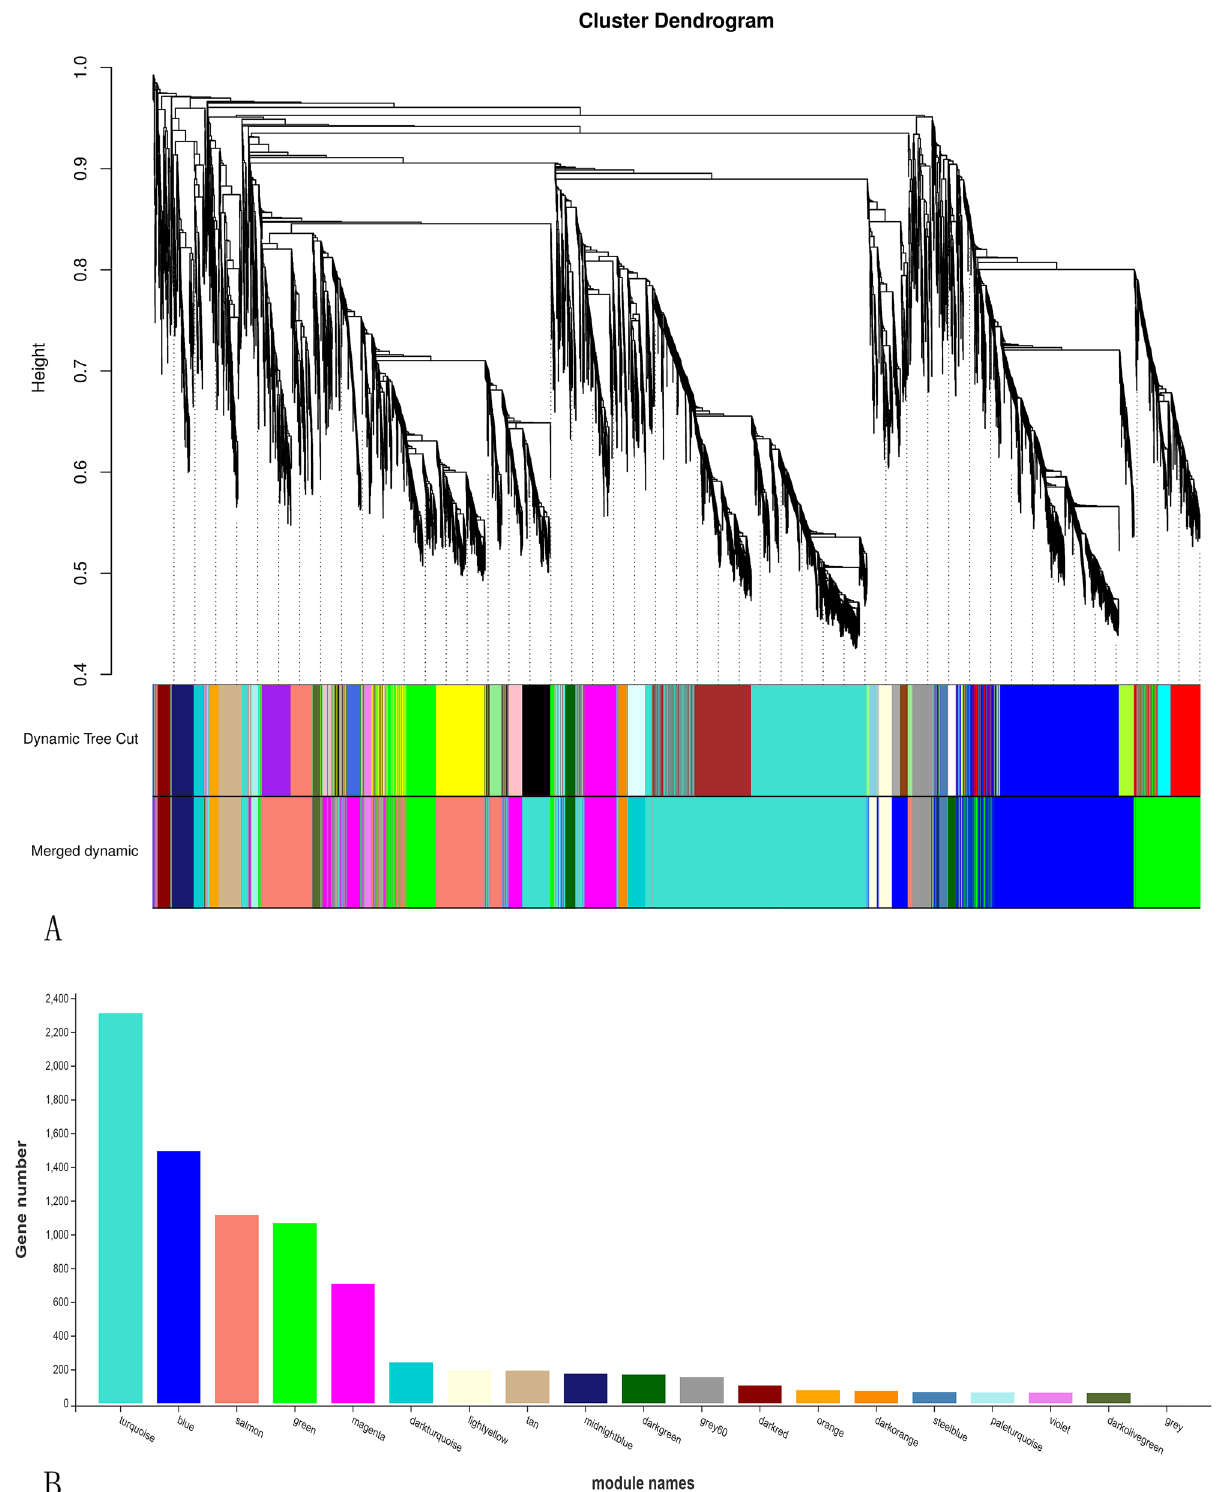
Figure 4. Nineteen different modules identified. ( A ) Gene co-expression network gene clustering number and modular cutting. Dynamic Tree Cut is the module divided according to clustering results. Merged Dynamic is the module division of merged modules with similar expression patterns according to module similarity. The subsequent analysis is conducted in accordance with merged modules. In the case of trees, the vertical distance represents the distance between two nodes (between genes), and the horizontal distance is meaningless. ( B ) Number of genes per module. The abscissa represents each module, and the ordinate represents the number of